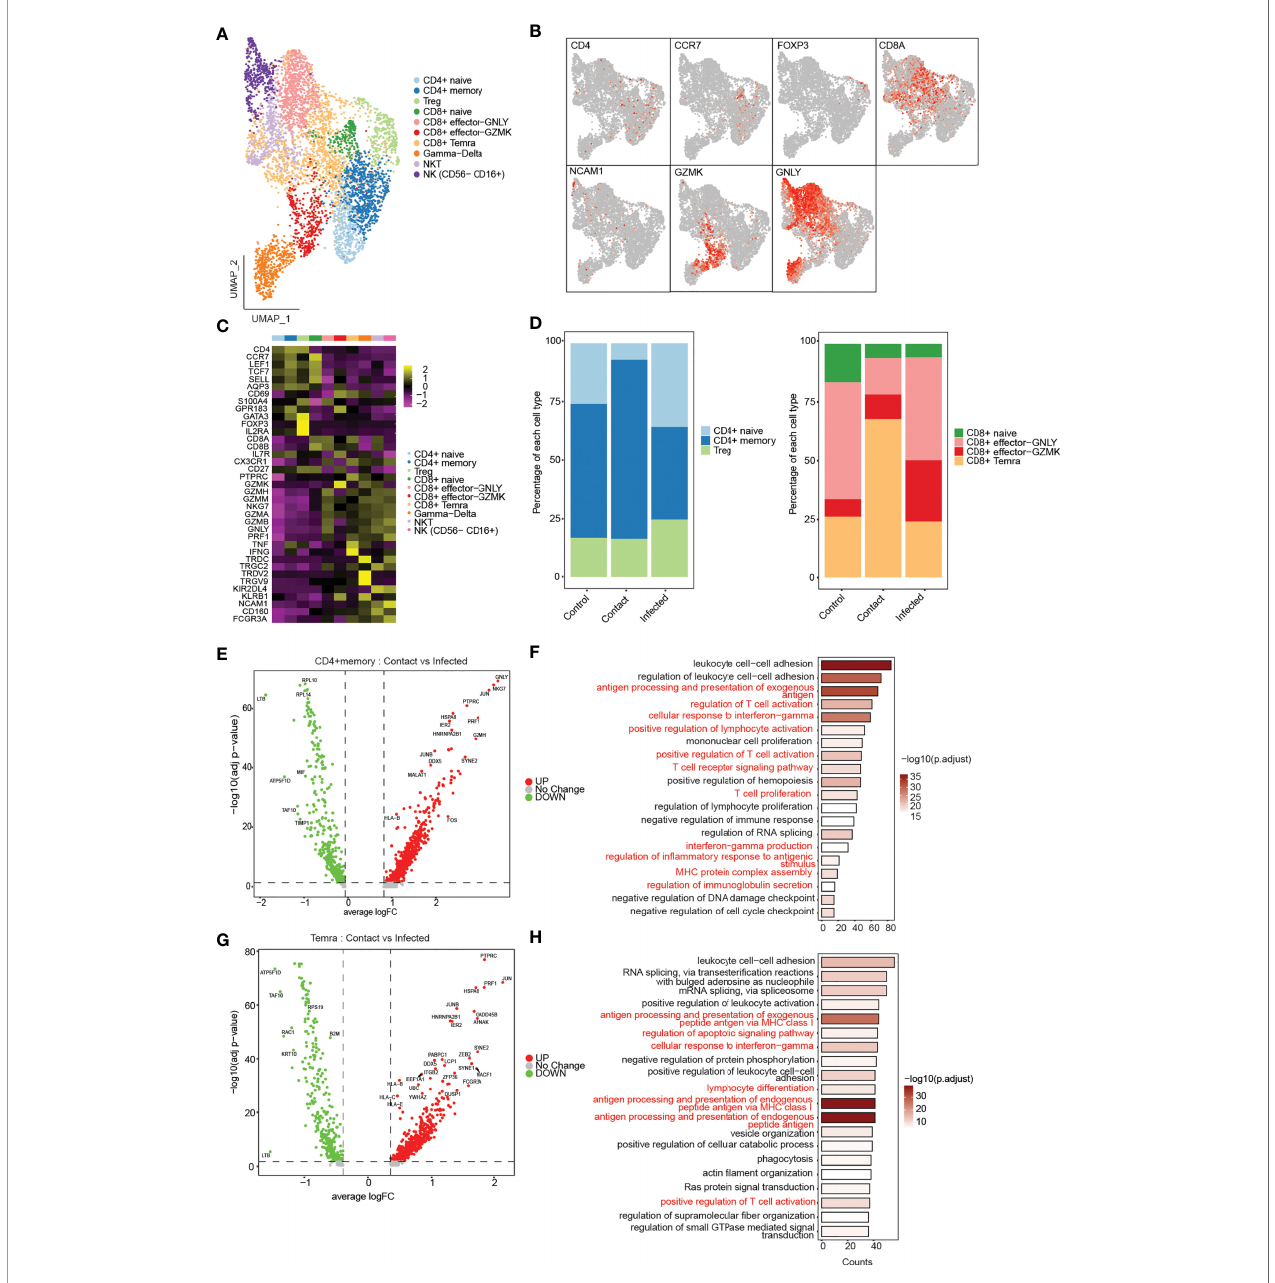
FIGURE 4 | Phenotypical characterization of T, NK, and NKT cells. (A) UMAP representation of 5,130 single cells, color coded according to T-cell subtypes. (B) UMAP representation of subtype-speci fi c marker genes: CD4, CCR7, FOXP3, C8A, NCAM1, GZMK, and GNLY . (C) Heatmap showing expression of marker genes for CD4 + naive ( CCR7 − , LEF1, TCF7, SELL ), CD4 memory ( AQP3, CD69 ), Treg ( FOXP3, IL2RA ), CD8 naive ( CCR7, LEF1, TCF7, SELL ), CD8 + effector GNLY ( GNLY, GZMH, NKG7 ), effector GZMK ( GZMK ), CD8 + Temra ( PTPRC, CX3CR1 ), gamma – delta ( TRDV2, TRDC, TRGV9 ), NKT ( NCAM1, KLRB1 ), and NK ( NCAM1 − FCGR3A + ). (D) Bar plot showing relative contribution of the three subclusters of CD4 + T cells (left), and four subclusters of CD8 + T cells in controls, contact, and patients (right). (E) Volcano plot showing the differentially expressed genes of CD4 + memory T cells between the contacts and infected patients. p-values were calculated using non- parametric Wilcoxon rank-sum test, and adjusted p-value were calculated based on the Bonferroni correction procedure. (F) GO BP enrichment analysis of differentially expressed genes upregulated in CD4 + memory T cells in contacts. p-values were calculated using non-parametric Wilcoxon rank-sum test, and adjusted p-value were calculated based on the Bonferroni correction procedure. (G) Volcano plot showing the differentially expressed genes of CD8 + Temra T cells between the contacts and infected patients. (H) GO BP enrichment analysis of differentially expressed genes upregulated in CD8 + Temra T cells in contacts. p-values were calculated using non- parametric Wilcoxon rank-sum test, and adjusted p-values were calculated based on the Bonferroni correction